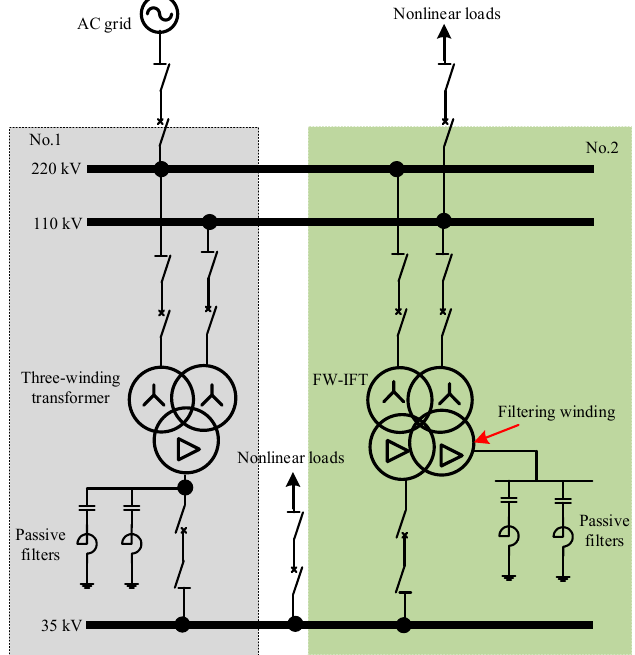
Figure 1. Main circuit topology for a high voltage (HV) distribution network with one passive filtering (unit No.1) and another inductive filtering (unit No.2). AC: alternative current; FW-IFT: four-winding inductive filtering transformer.